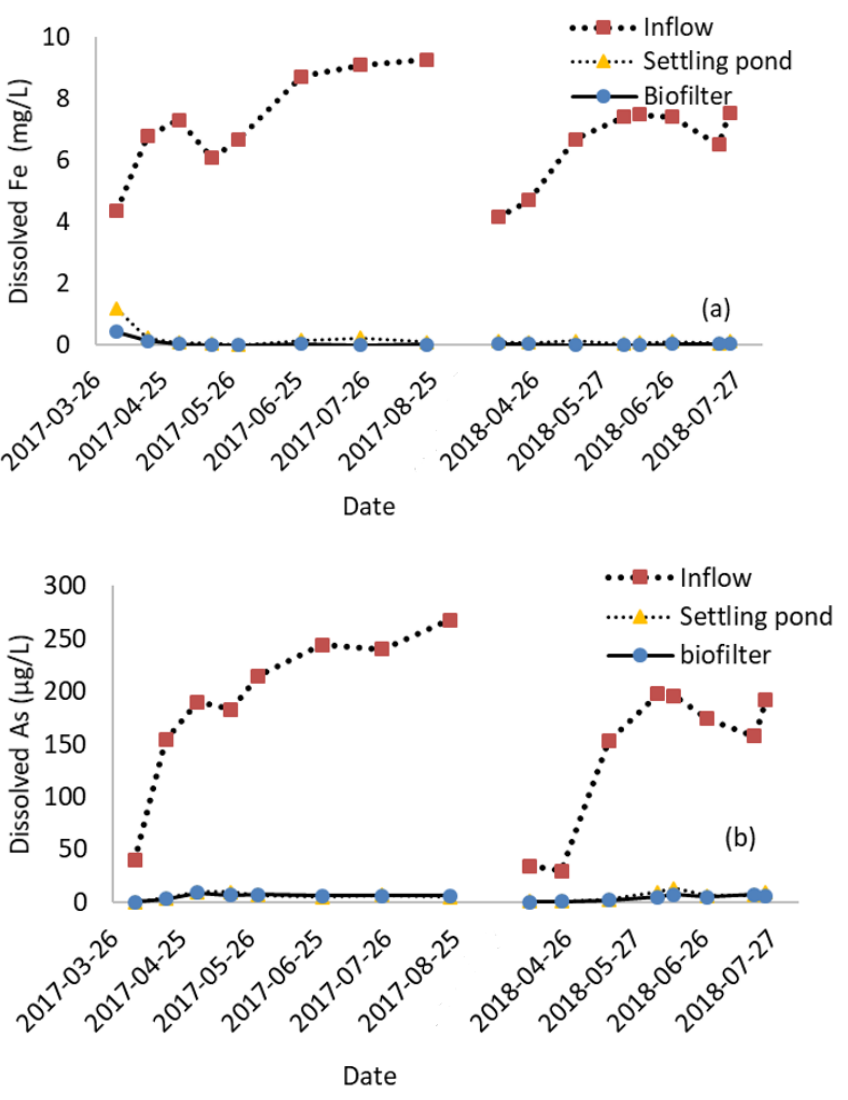
Figure 3. Dissolved Fe ( a ) and As ( b ) concentrations.